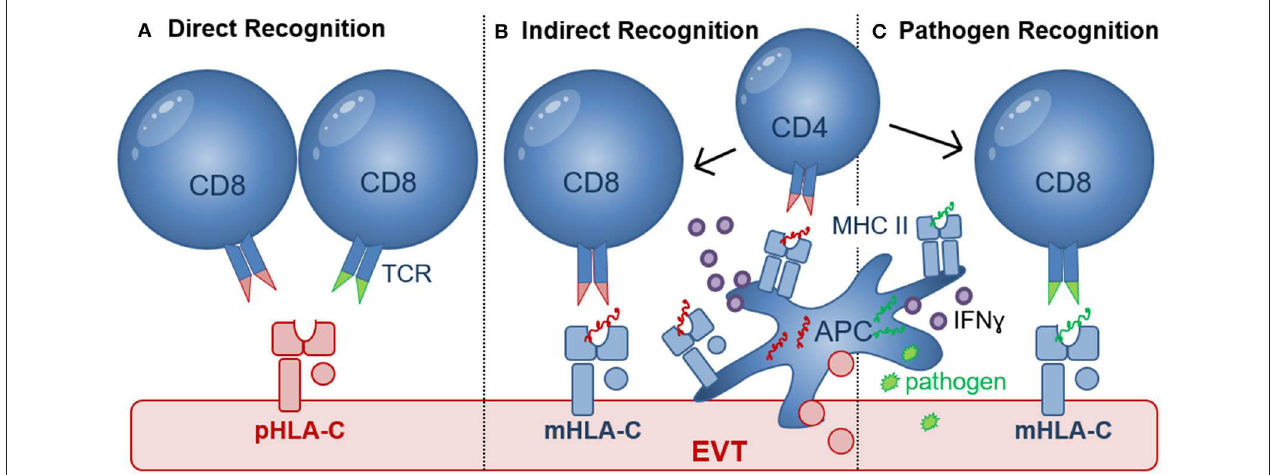
FIGURE 3 | Recognition of HLA-C by CD8 + T cells. (A) Direct recognition of allogeneic paternal HLA-C (pHLA-C, depicted in red) occurs through allo-specific CD8T cells (left) and cross-reactive memory CD8 + T cells (right); (B) Indirect recognition of allo-antigens occurs when APC process and present allogeneic peptide antigens to activate CD8 + T cells in a process where CD4 + T cells may be involved. Differentiation of CD4 + and CD8 + T cells depends on the presence of pro-inflammatory (e.g., IFN È , TNF α , and IL-12) and anti-inflammatory (e.g., IL-10) cytokines produced by APC or other cell types in the placental microenvironment. Activated HLA-C restricted CD8 + T cells may recognize paternal peptide antigens presented in by maternal HLA-C (mHLA-C, depicted in blue); (C) Pathogen-derived peptide antigens (green) presented by HLA-C can activate HLA-C-restricted pathogen-specific CD8 + T cells. Efficient priming of pathogen-specific CD8 + T cells depends on antigen presentation by APC, CD4 + T cell help as well as the presence of pro-inflammatory (e.g., IFN È , TNF α , and IL-12) and anti-inflammatory (e.g., IL-10)